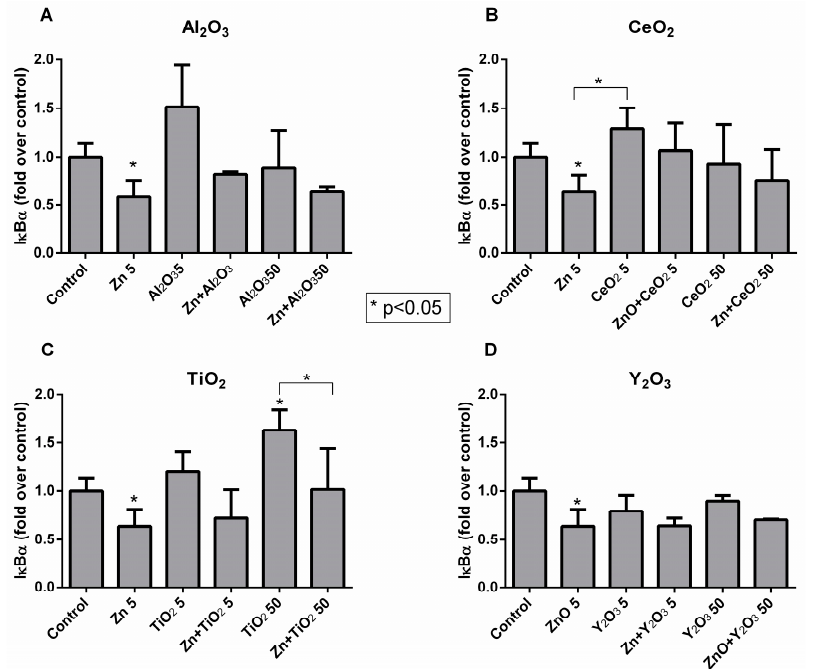
Figure 4. Expression of I κ B α in Jurkat cells. The graphics show the expression of I κ B α in cells treated with Al 2 O 3 ( A ), CeO 2 ( B ), TiO 2 ( C ), Y 2 O 3 ( D ) Nps at different concentrations (5 and 50 µg/mL) and combined with 5 µg/mL ZnO Nps for 3 h. Asterisks are used to indicate statistically significant differences between treated cells and untreated cells (control). Lines and asterisks mark differences between treated cells.